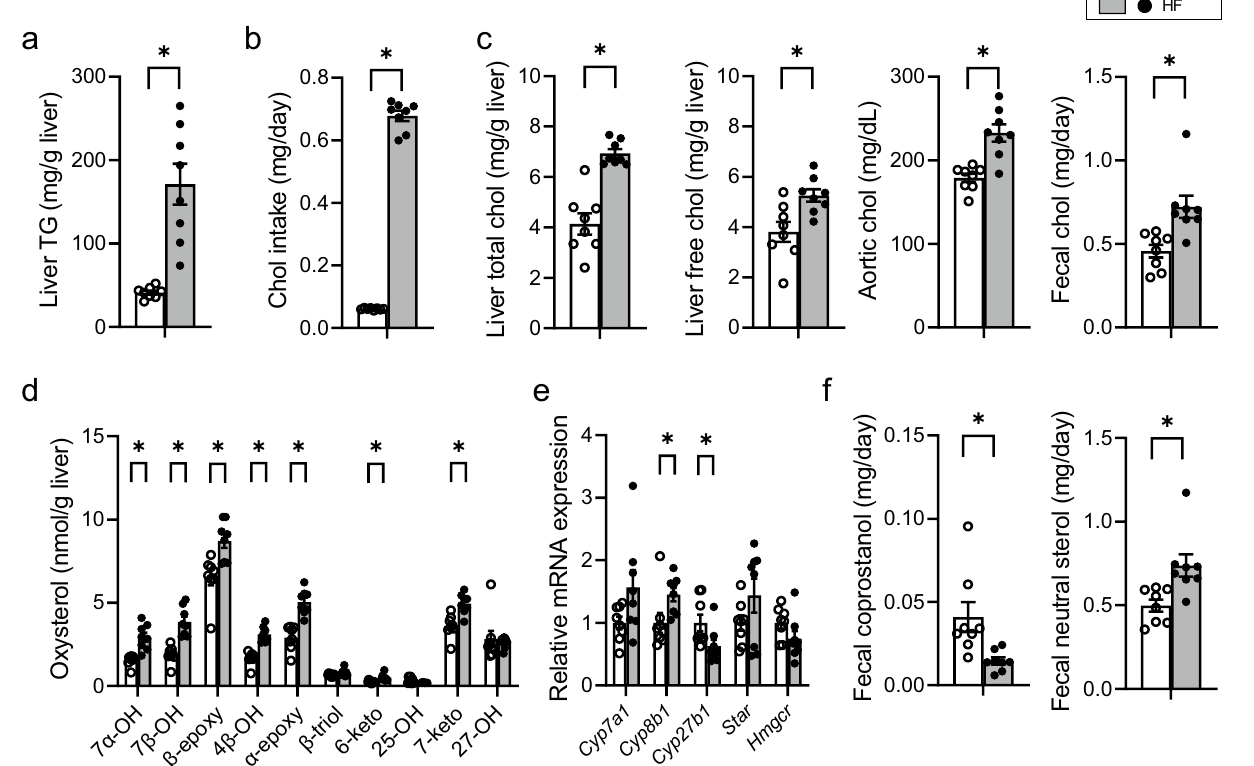
Figure 1. Distribution of chol-related molecules in mice fed control or HF diet. ( a ) Hepatic TG concentration. ( b ) Daily chol intake. ( c ) Chol concentration in the liver, blood, and feces. ( d ) Concentration of liver oxysterols. ( e ) mRNA expression of genes involved in chol metabolism. ( f ) Coprostanol and neutral steroid excretion per day. Open bars, n = 8 for control; filled bars, n = 8 for HF. Data presented in E was normalized to Gapdh mRNA expression. Values are shown as the mean ± SEM (n = 8). Asterisks indicate a significant difference compared with the control ( P <